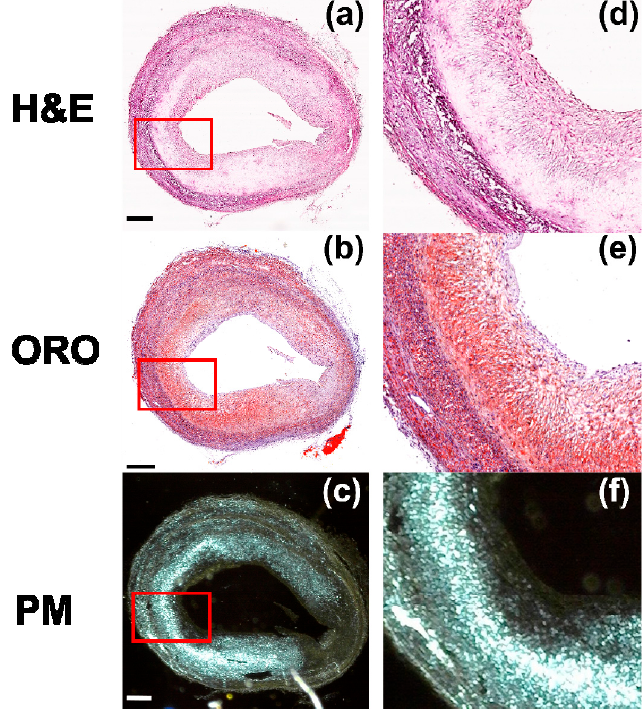
Figure 6. Microscopic images of artery samples with advanced fibroatheroma stained with ( a ) Hematoxylin and Eosin (H&E) and ( b ) Oil-Red-O (ORO). ( c ) Polarization microscopic image of an unstained sample. ( d – f ) are magnified images of the red box in ( a – c ), respectively. Scale bars: ( a – c ) 500 μ m and ( d – f ) 200 μ m.